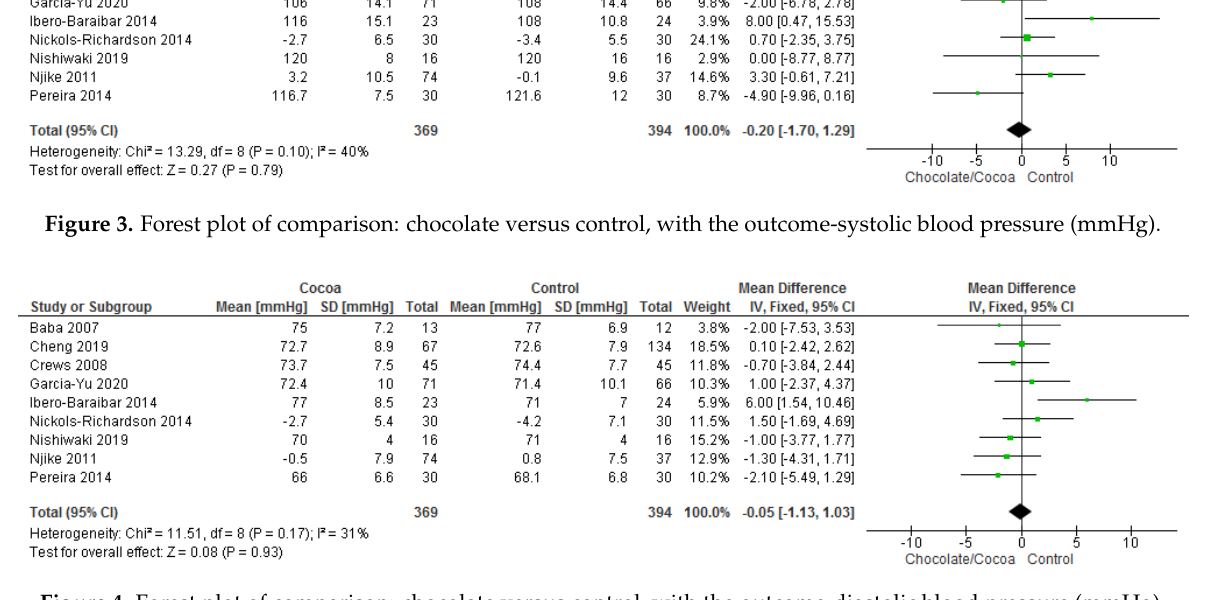
Figure 7. Forest plot of comparison: chocolate versus control, with the outcome - low density lipoprotein (mg/dL). Nichols- Richardson (2014) and Nijike (2011) reported mean changes and their respective SD, instead of mean scores. Figure 8. Forest plot of comparison: chocolate versus control, with the outcome - high density lipoprotein (mg/dL). Nichols- Richardson (2014) and Nijike (2011) reported mean changes and their respective SD, instead of mean scores.